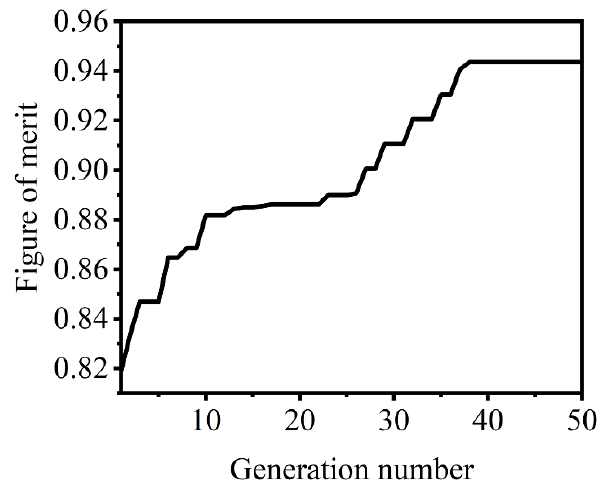
Figure 3. FOM trend for the PSO simulation.